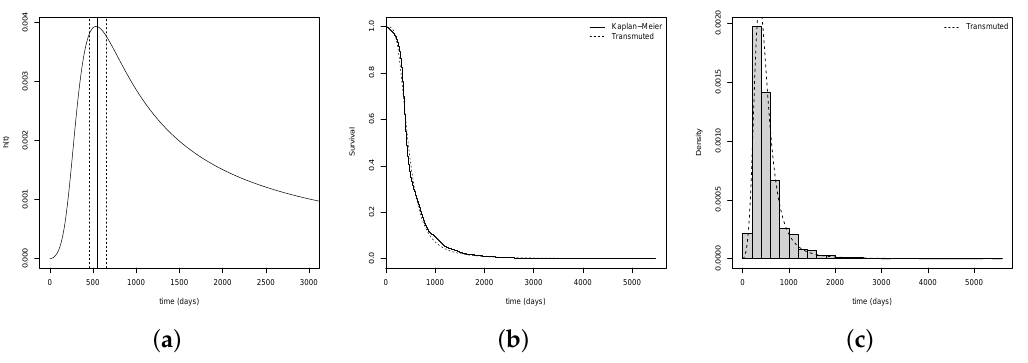
Figure 5. ( a ) hazard estimate curve, with the ˆ T max and the T max 95% confidence interval, ( b ) survival curves and ( c )